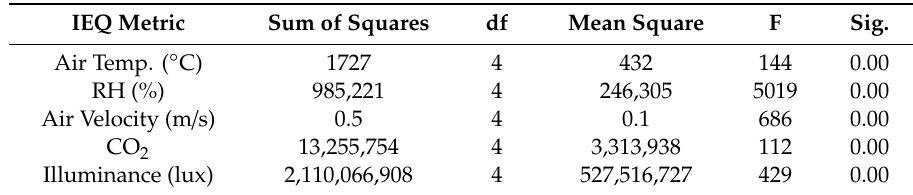
Table 7. One-Way ANOVA Summary Table for Measured IEQ Variables by